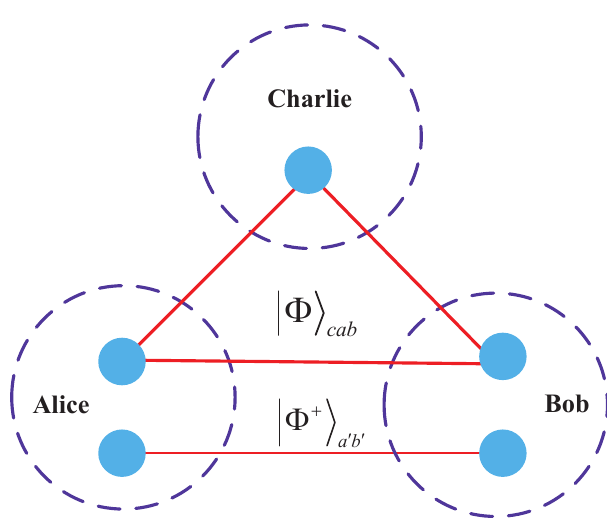
Figure 2. Particle distribution in two-qubit Fig. 2. Particle distribution in two-qubit CRSP.